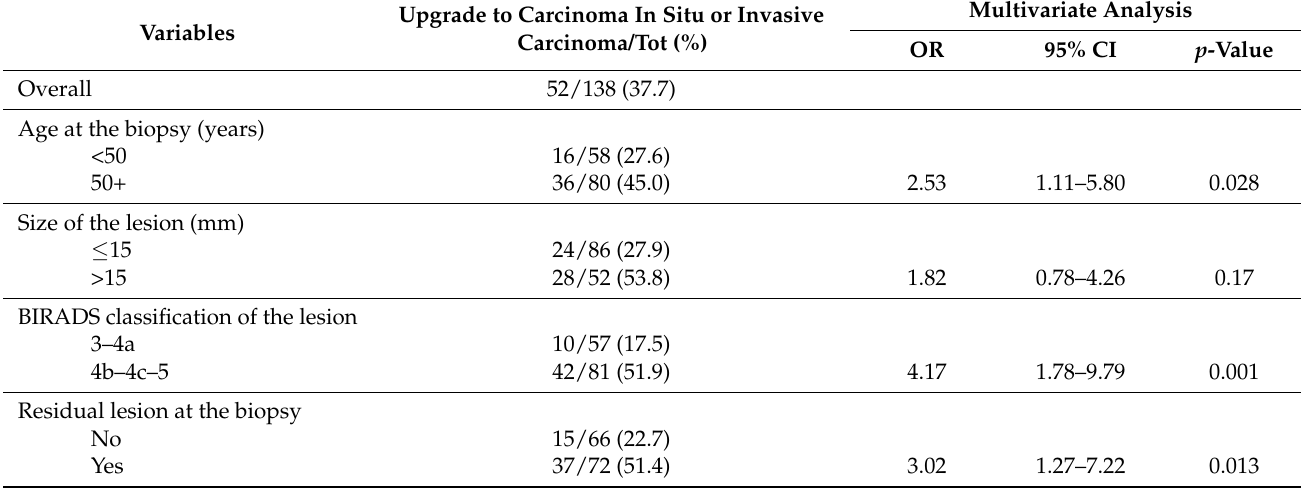
Table 3. Multivariate analysis considering the upgrade from ADH to either DCIS or invasive disease as the outcome